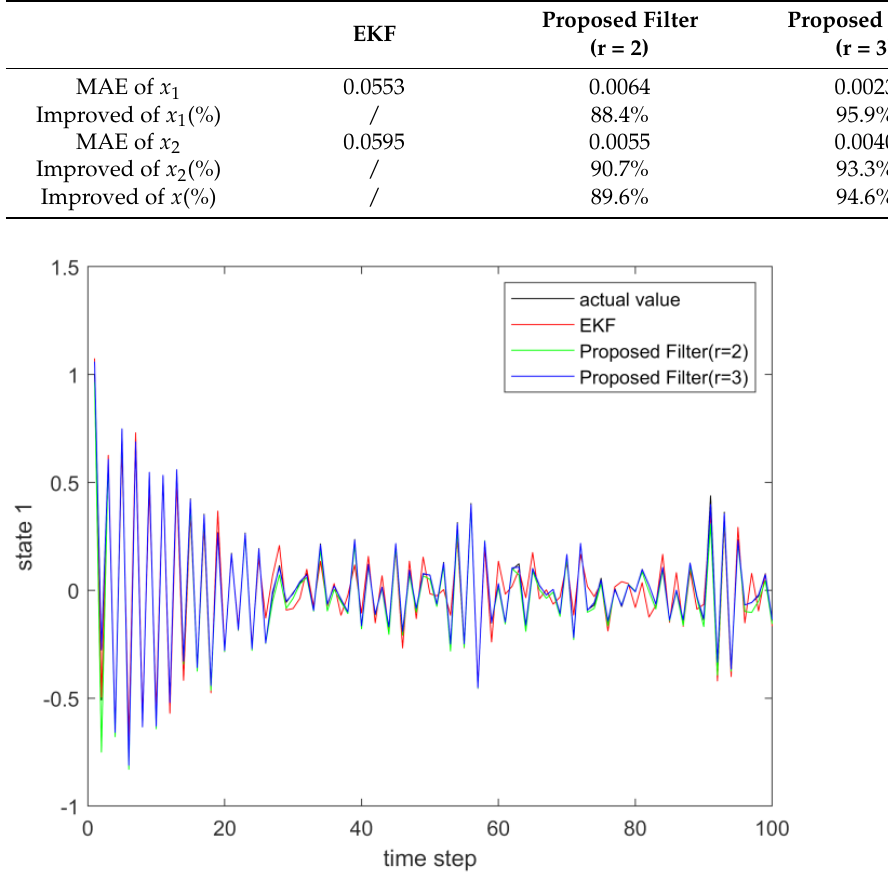
Figure 9. The actual value of state 1 and its estimation.